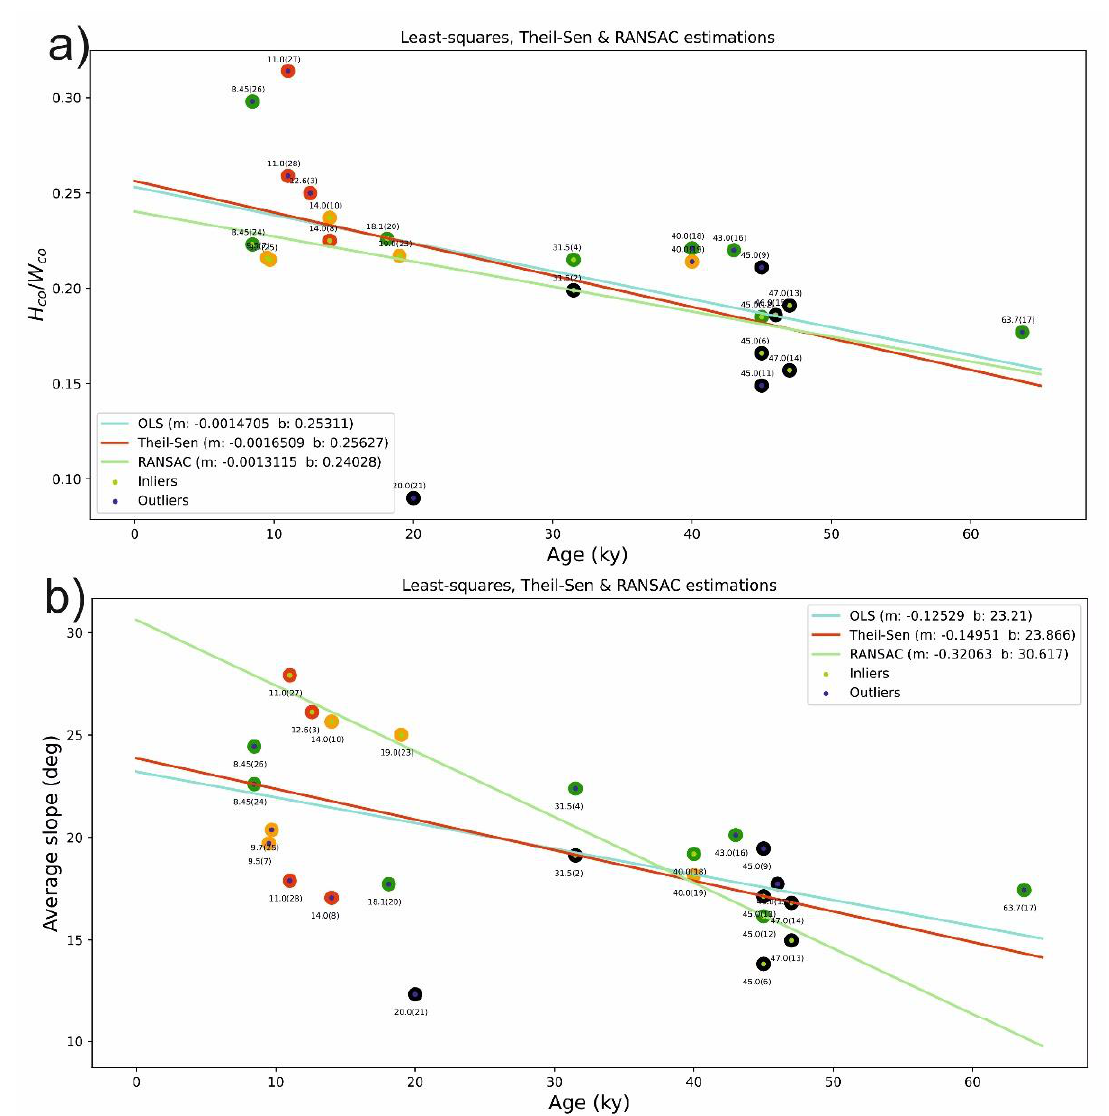
Figure 17. ( a ) regression models for age vs. H co / W co ratio. All three models are similar with many outliers; ( b ) regression models for age vs. (DTM-based) average slope. RANSAC results in a completely different model, whereas the results of ordinary least squares fit and Theil–Sen estimator are similar.